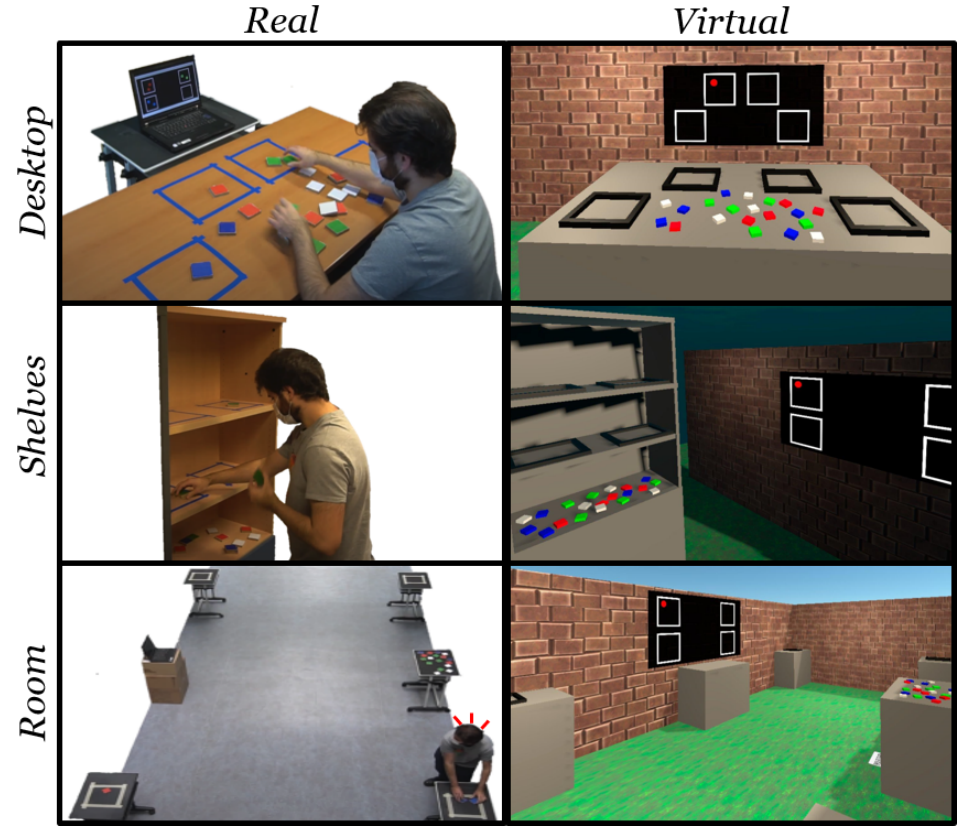
Figure 4. The scenarios for real and virtual conditions. In the Desktop scenario, the user was seated in front of a desk. In the Shelves scenario, the user had to grasp the tokens on the lowest shelf and place them on the middle or upper shelf. In the Room scenario, the user walked inside a room (7 m × 4 m) to move the tokens between the small